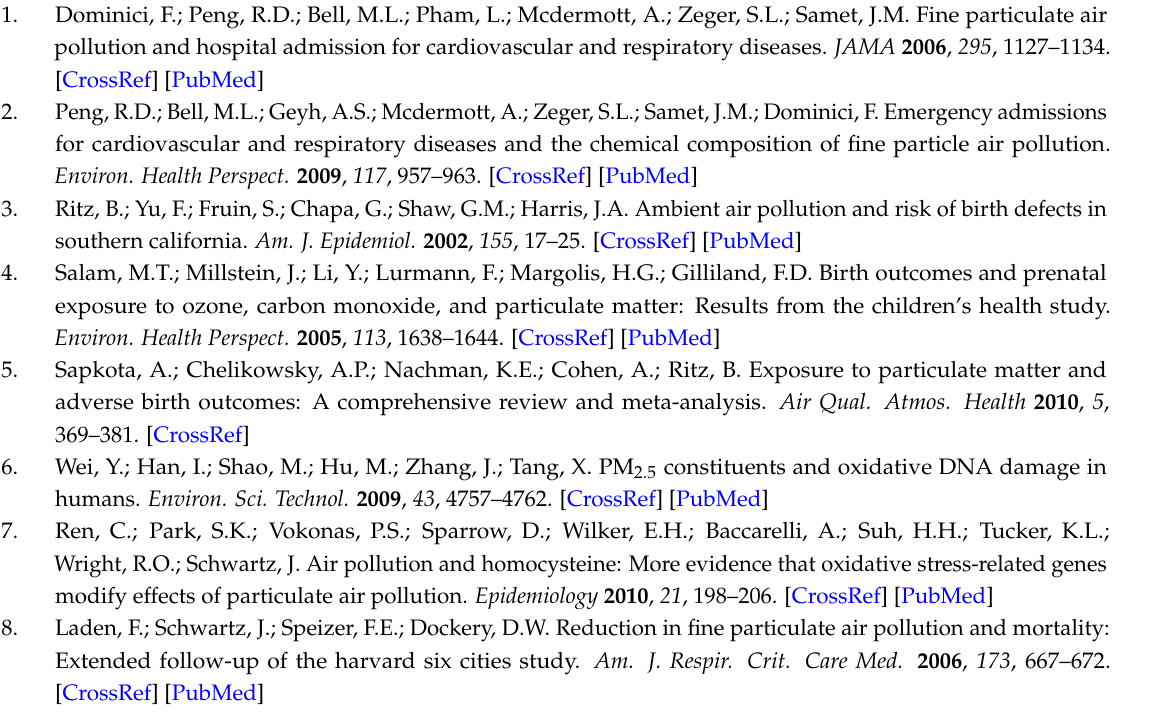
Figure S1: Scatterplots to compare CV 10 and CV IS using AOD-derived PM 2.5 from a LME model, Figure S2: Scatterplots of cross-validated values and their monthly or annual averages for downscaled CMAQ PM 2.5 (0.1 ◦ × 0.1 ◦ ), Figure S3: Scatterplots of cross-validated values and their monthly or annual averages for raw CMAQ PM 2.5 (36 km × 36 km), Figure S4: Seasonal maps of PM 2.5 in 2014 over China, produced by CMAQ, intermediate and final estimators of the three-stage model, Figure S5: Comparisons of coverage rate (CR) of AOD-derived PM 2.5 by groups of observational PM 2.5 at the CV IS testing sites, Figure S6: Temporal variations of CV results for the final estimator (PM 2.5Optimal ), Figure S7: Spatial distributions of CV results for the final estimator (PM 2.5Optimal ), Figure S8: Distributions of coefficients for AOD by months (upper panel) and their spatial patterns by seasons (lower panel) in Equation (1), Figure S9: Distributions of coefficients for CMAQ-simulated PM 2.5 by months (upper panel) and their spatial patterns by seasons (lower panel) in Equation